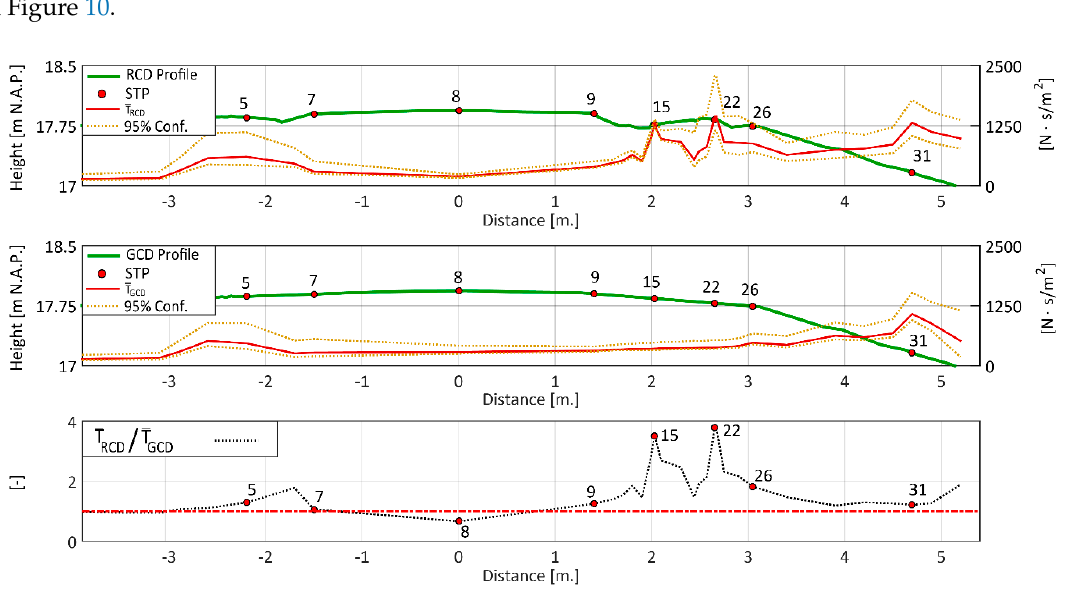
Figure 10. Mean values of T (red line, right axis) and 95% confidence intervals (dashed lines) for RCD (upper plot) and GCD (middle plot). Lower plot shows ratios of RCD and GCD mean T values at each location.